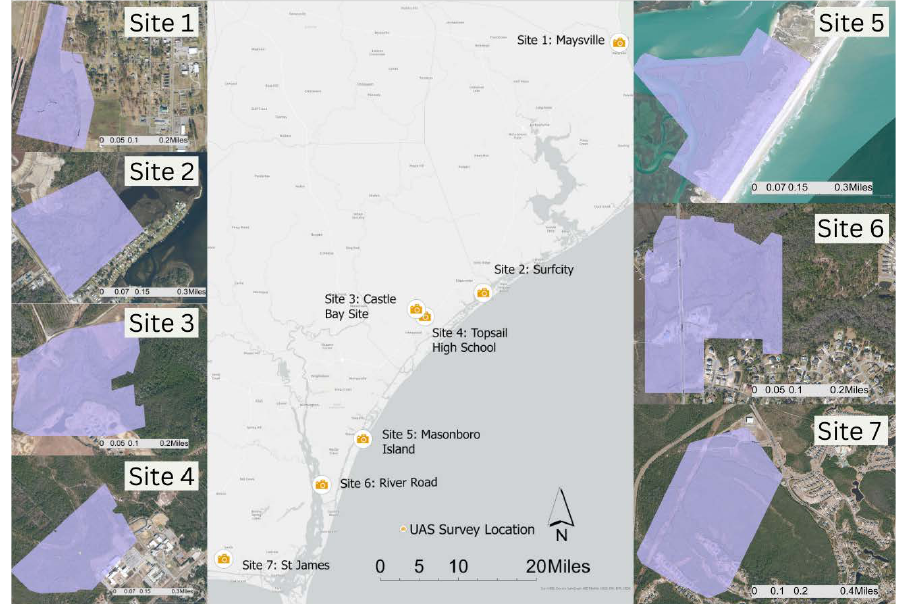
Figure 1. Study area in southeastern North Carolina, United States and the associated survey locations for each site.